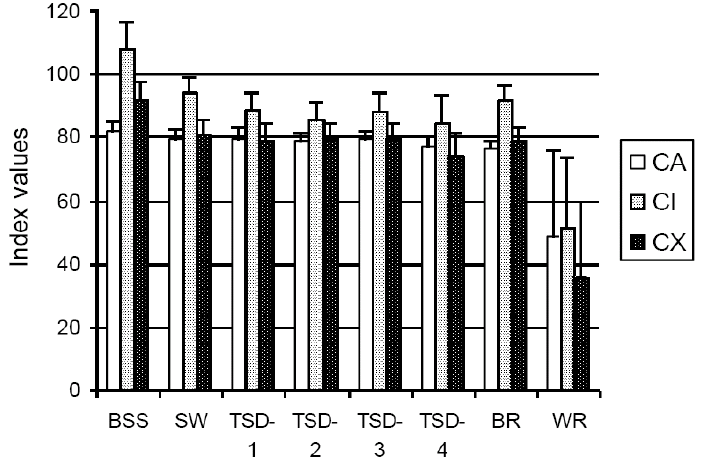
Figure 2. Wood-cement compatibility indexes (beetle-killed lodgepole pine and Portland